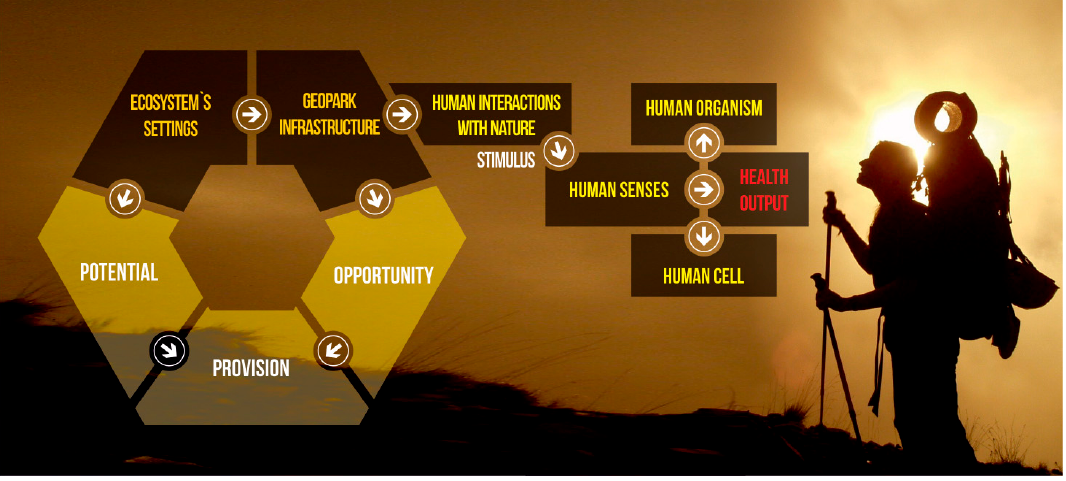
Figure 1. A conceptual research framework to ecosystems’ health provision spectrum for geoparks.